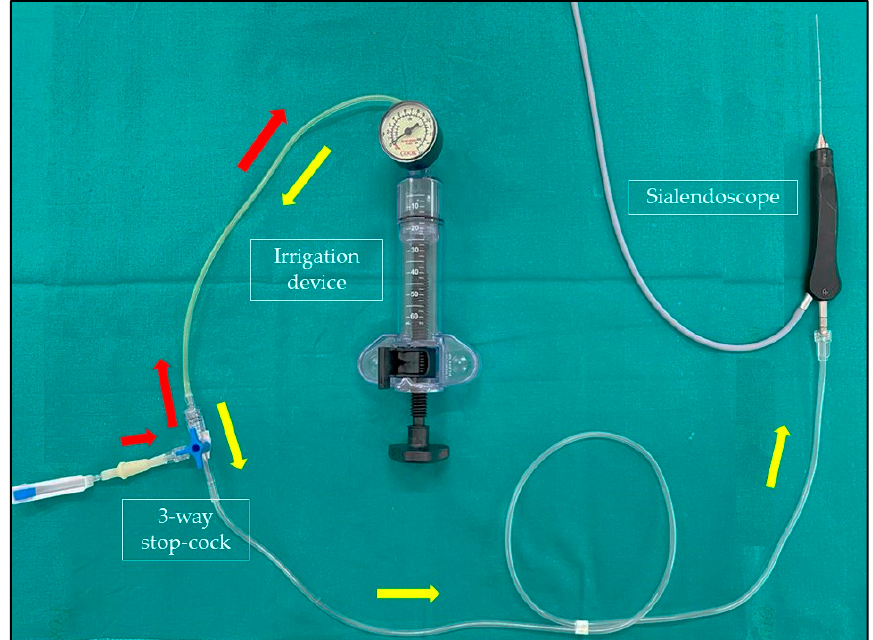
Figure 2. The irrigation device is connected with the irrigation channel of the sialendoscope and a saline solution bottle through a three-way stop-cock. Red arrows: saline solution is drawn into the syringe through the three-way stop-cock. Yellow arrows: saline solution is pushed into the sialendoscope through the three-way stop-cock under pressure control to perform an adequate duct dilatation.